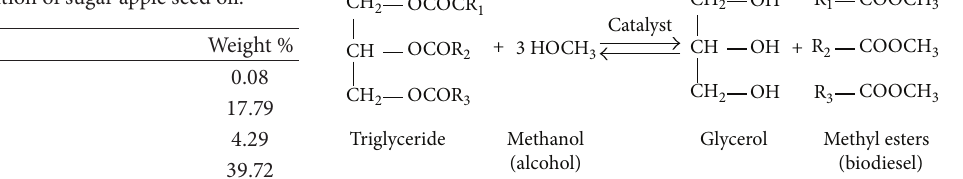
Table 1: Fatty acid composition of sugar apple seed oil.